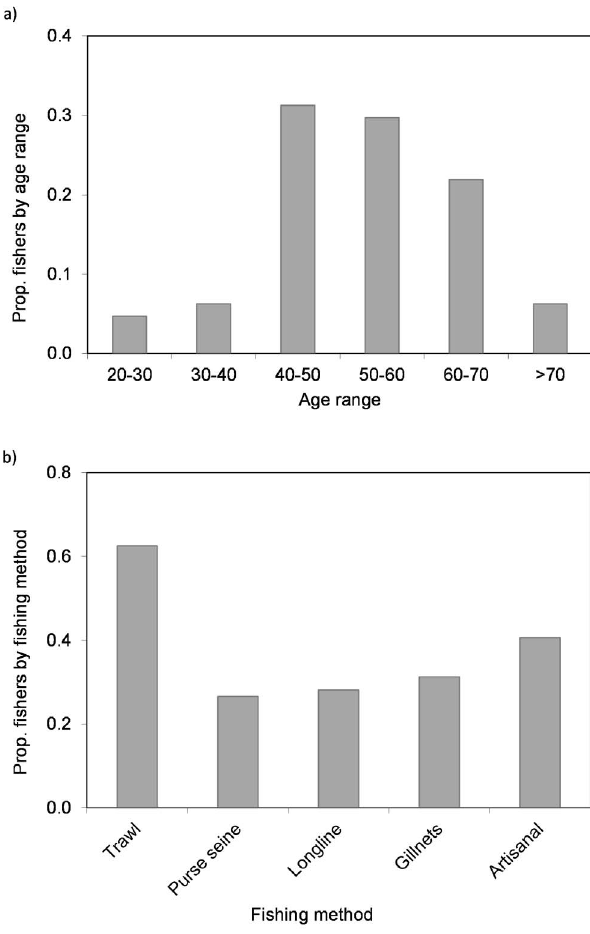
Figure 2. Proportion of a) fishers interviewed by age range (n=64), and b) fishing methods used by fishers. In Figure 2b fishers can be represented more than once due to results integrate their knowledge through their entire working life, thus the total proportions do not sum to 1.